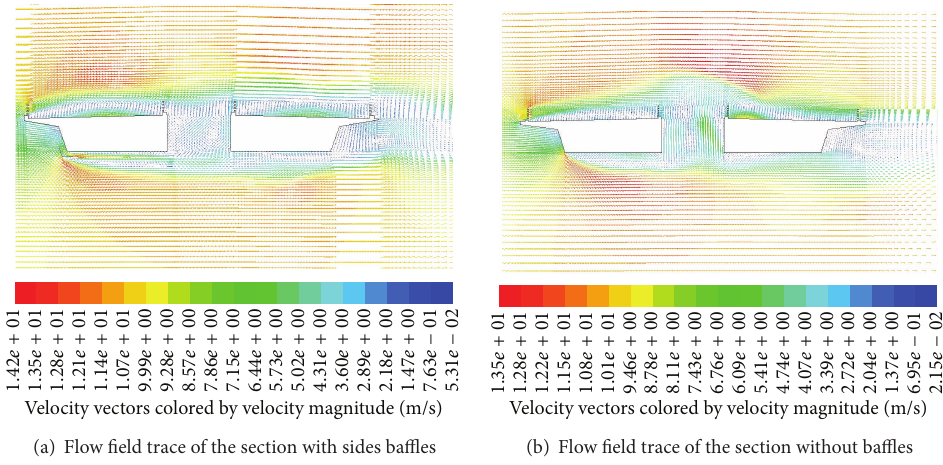
Figure 12: Flow field trace of the section with baffles at wind attack angle of 0 deg.